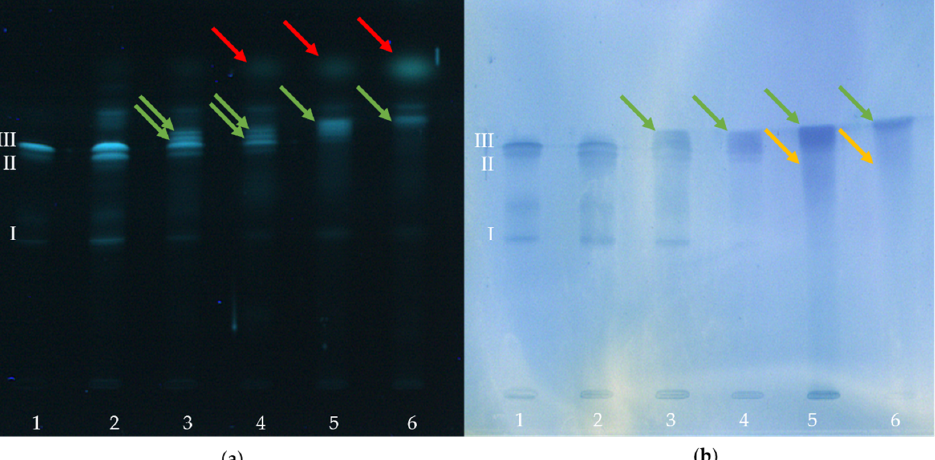
Figure 2. HPTLC analysis of BITC- α -LA derivatives as a function of the concentration of BITC. ( a ) Protein-specific staining with fluorescamine (UV-light; λ = 366 nm); ( b ) Immunostaining with antibodies (white light) for the exclusive detection of the antigen. (1) α-LA control (freshly prepared), (2) α-LA control (treated similar as BITC-protein derivatives), (3) BITC-α-LA derivative “low” (c BITC = 3.8 mM), (4) BITC-α-LA derivative “moderate” (c BITC = 38 mM), (5) BITC-α-LA derivative “high” (c BITC = 75 mM); (6) BITC-α-LA derivative “very high” (c BITC = 113 mM).